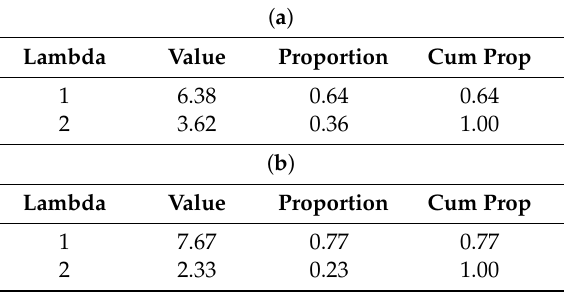
Table 4. ( a ) Eigenvalues/Analysis of Results. 3 ( b ) Eigenvalues/Analysis of Impacts. 4